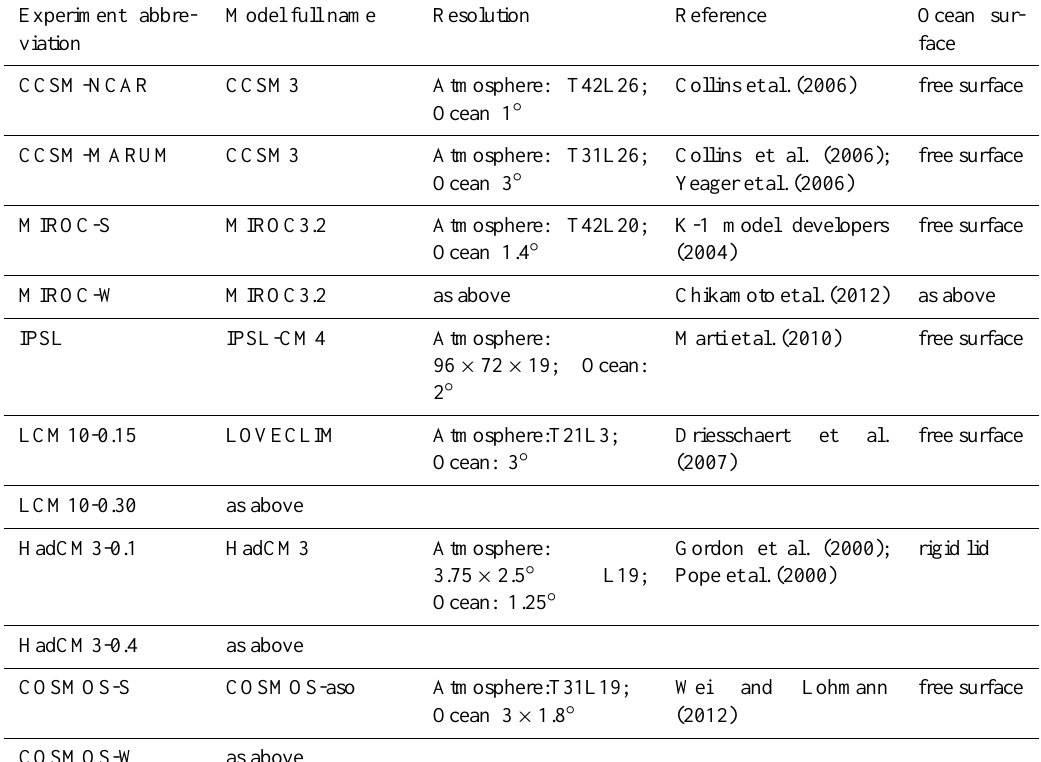
Table 1. Models compared in this